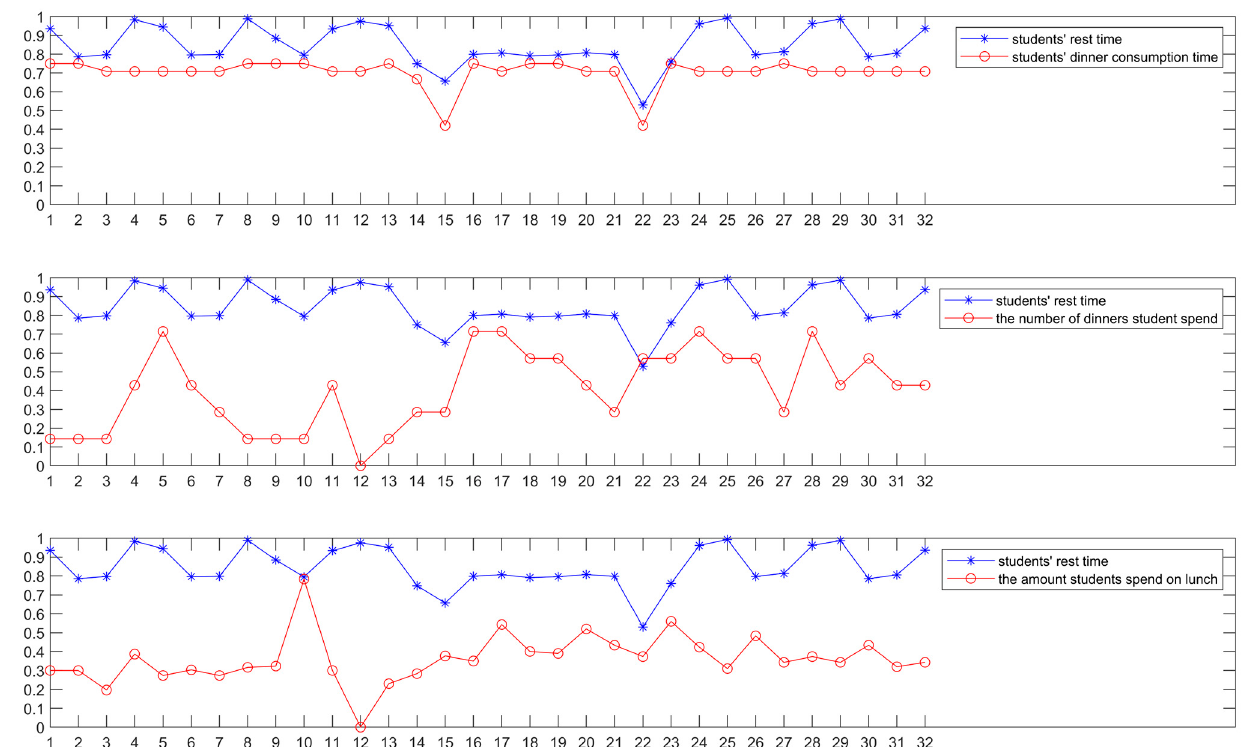
Figure 5. Drawing of the raw time series in different behavior pairs.